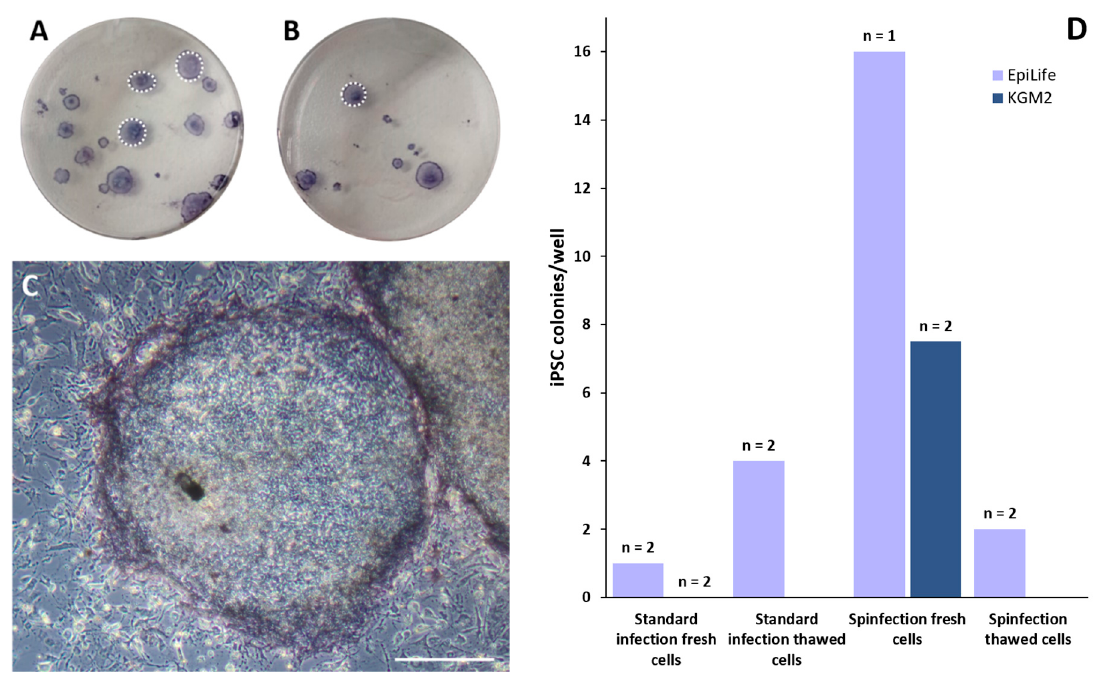
Figure 8. Reprogramming of HF-derived keratinocytes with different methods. Alkaline phosphatase (AP) staining of reprogrammed keratinocytes from the EpiLife medium ( A ) and KGM2 ( B ). Exemplary dotted lines mark the alkaline-phosphatase-positive iPSC colonies. ( C ) Higher magnification of AP- positive iPSCs growing on the MEF feeder layer. ( D ) Graph shows the amount of AP-positive iPSC colonies per well using different infection media and methods. N = number of single, independent experiments. Scale bar: 500 µ